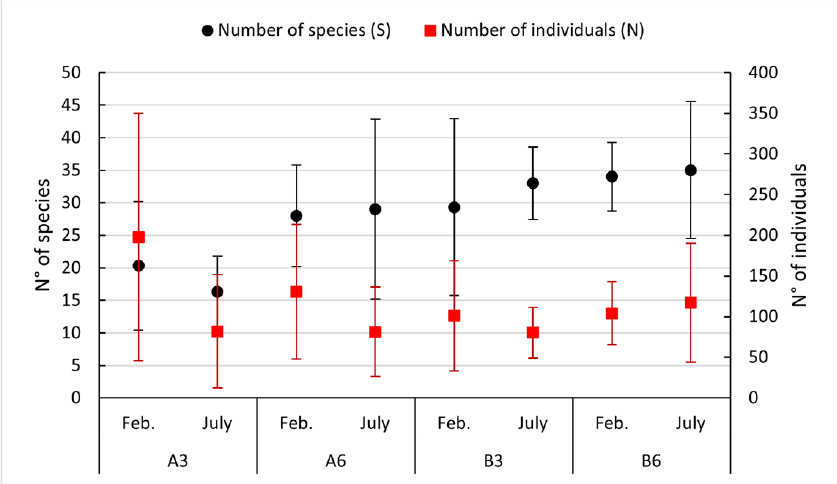
Figure 5. Trends of abundance and species richness in the study sites in the year 2018. Among polychaetes, the families Cirratulidae and Spioniidae were well represented in a number of species, but the most abundant species were Capitella capitata , (Fabricius, 1780), Cirrophorus nikebianchii Langeneck et al., 2017, Prionospio malmgreni Claparède, 1869, Micronephthys longicornis (Perejaslavtseva, 1891), Armandia cirrhosa Filippi, 1861, Cirri- formia tentaculata (Montagu, 1808), and Heteromastus filiformis (Claparède, 1864). The identified communities were typical of confined environments, characterized by a high organic content, as demonstrated by the presence of C. capitata , Malacoceros fuligi- nosus (Claparède, 1868), H. filiformis , and Gallardonereis iberica Martins et al., 2012, but also the mollusk Varicorbula gibba (Olivi, 1792), which is an indicator of sediment instability. As regards the AMBI index, Station A3 showed a value of 5.06 in February and a value of 4.78 in July, corresponding to a heavily disturbed site and a moderate disturbed site, respectively. The remaining stations, A6, B3, and B6, showed lower AMBI values, corresponding to a slightly disturbed site in all the sampling campaigns (Table 7, Figure 6). Table 7. Biotic indices values. Key: station (St.), AZTI’s Marine Biotic Index (AMBI), Multivariate- AMBI (M-AMBI), Ecological Quality Ratio (EQR). FEBRUARY 2018 St. I ( % ) II ( % ) III ( % ) IV ( % ) V ( % ) Richness Diversity Mean AMBI